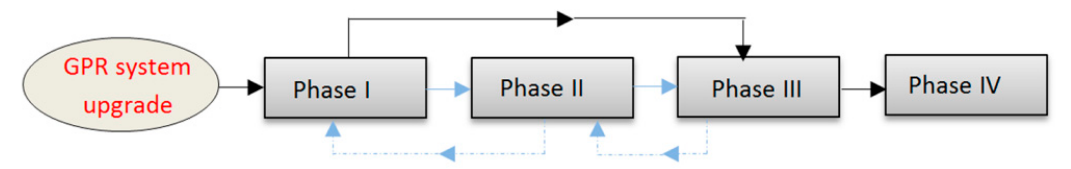
Figure 11. Schematic flow diagram of the basic steps of the developed GPR-TPS model.